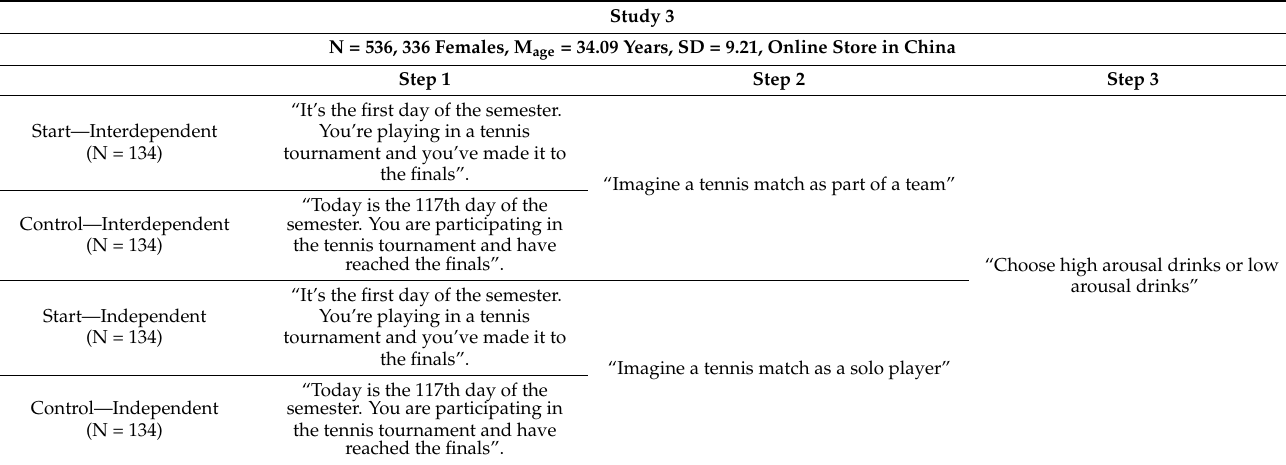
Table 6. Participants and procedure in Study 3.